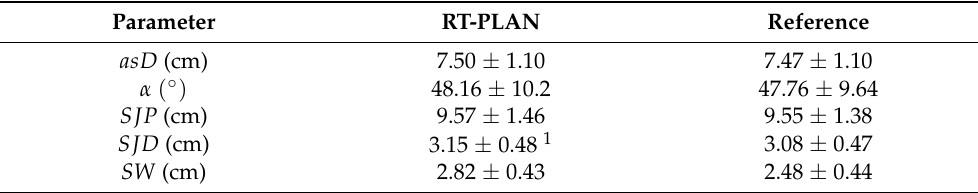
Table 1. Comparison between the reference method and the RT-PLAN tool for direct and derived measures.